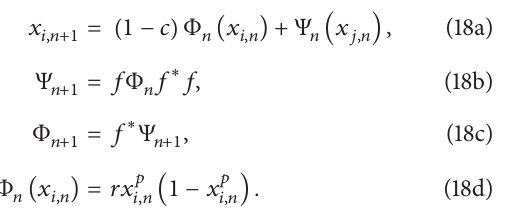
among the components can be either global or local.